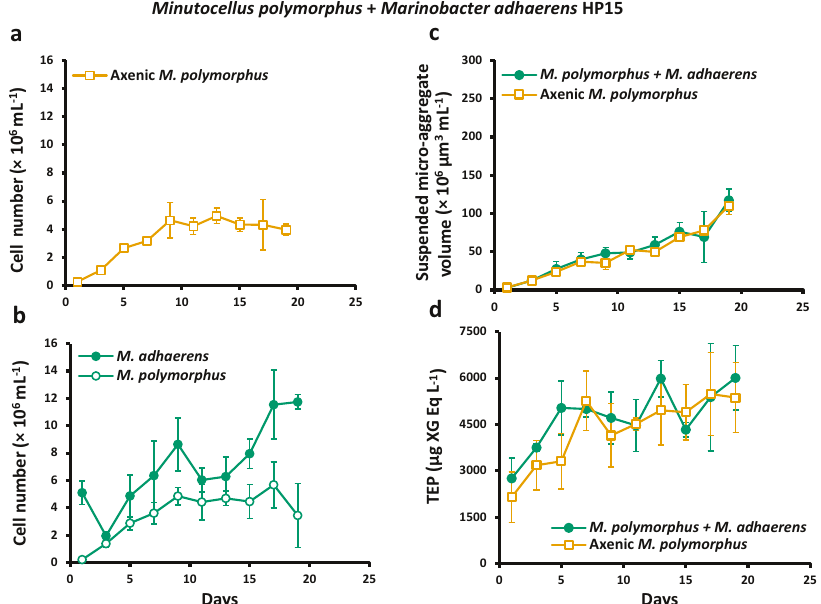
Fig. 1 Cell growth, TEP concentration, and micro-aggregate (5 – 60 μ m) volume concentration in Minutocellus polymorphus co-cultures with Marinobacter adhaerens HP15. Diatom cell concentration in growth experiment 1 with axenic Minutocellus polymorphus ( a ) and diatom and bacteria cell concentration in co-culture treatments with M. polymorphus and the addition of Marinobacter adhaerens HP15 ( b ), as well as total volume of suspended micro-aggregates ( c ) and transparent exopolymeric particle (TEP) concentrations ( d ) in all treatments. Symbols and error bars denote the means and standard deviations of triplicate